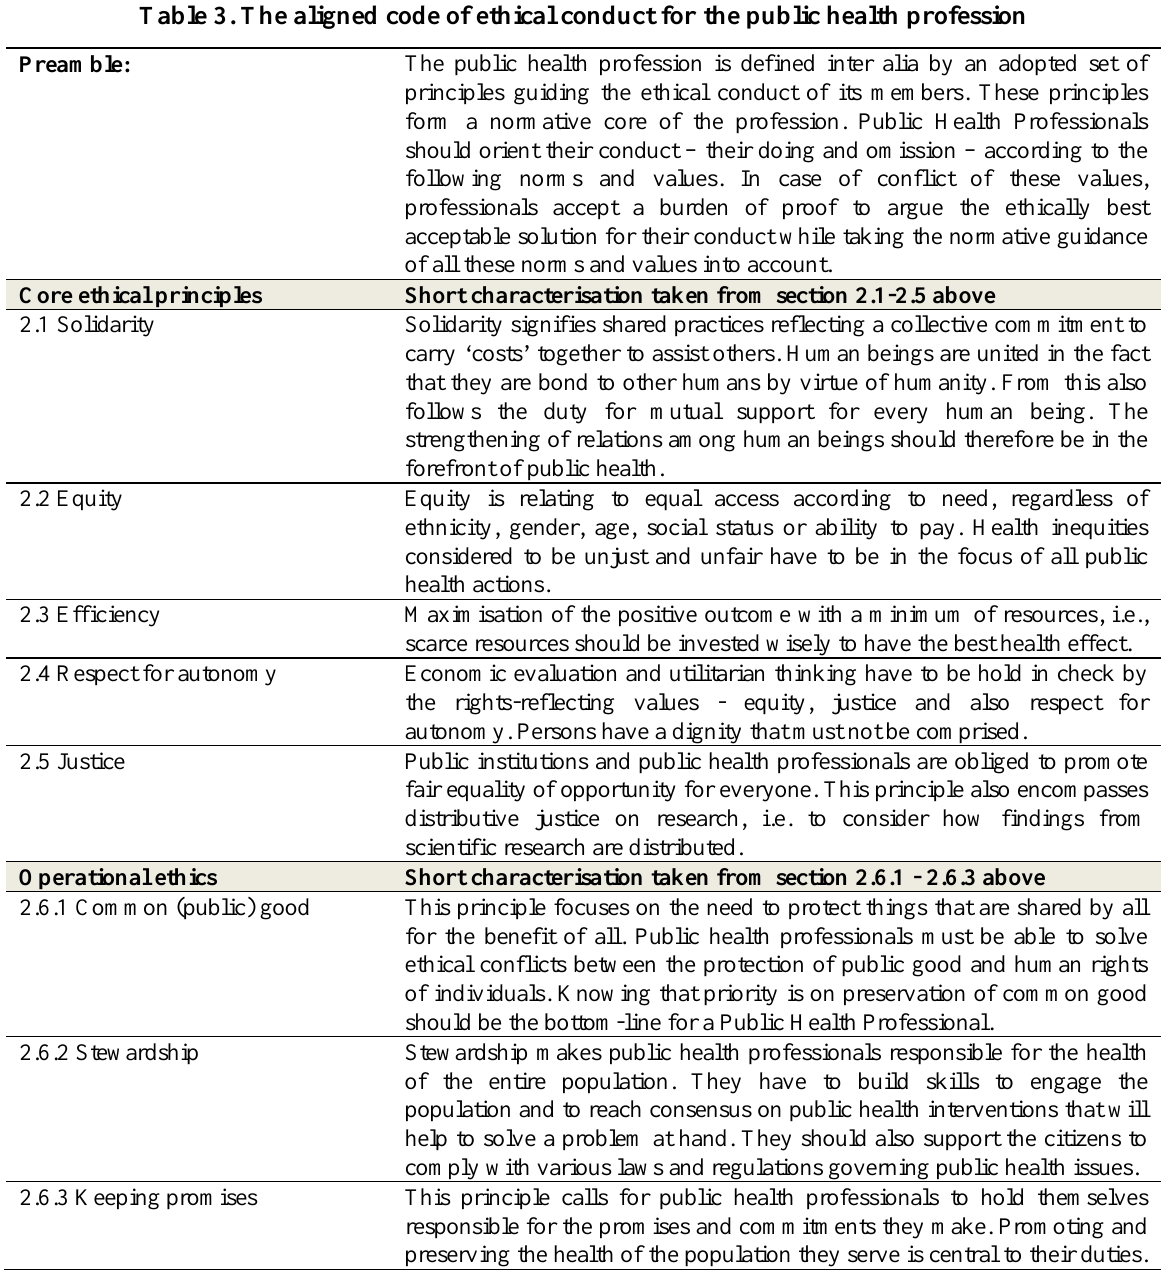
Table 3. The aligned code of ethical conduct for the public health profession